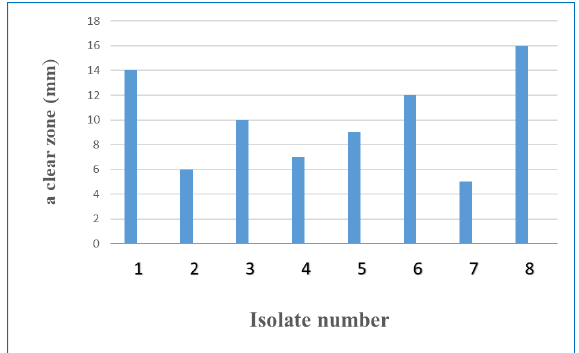
Figure , 3: The activity of purified enzyme on HepG2 cell line viability.